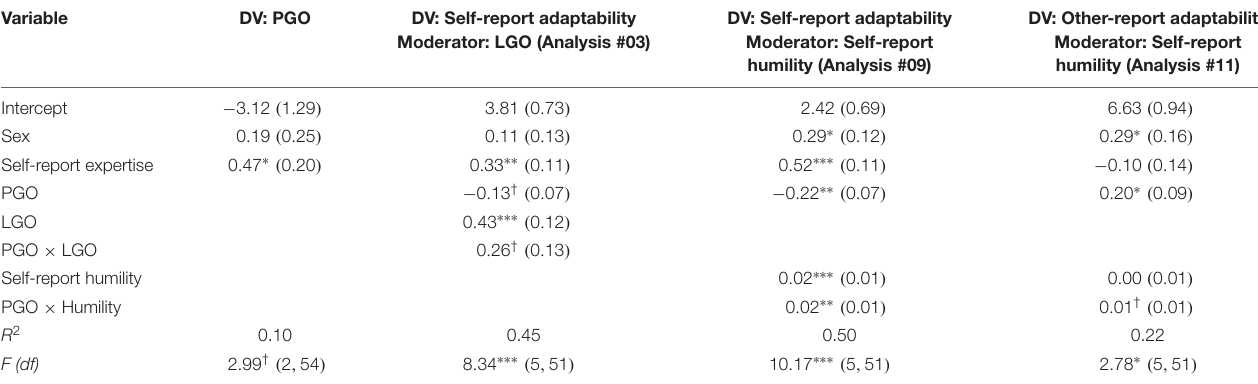
TABLE 4 | Results of conditional process analyses #03, 09, and 11. Variable DV: PGO DV: Self-report adaptability Moderator: LGO (Analysis #03)